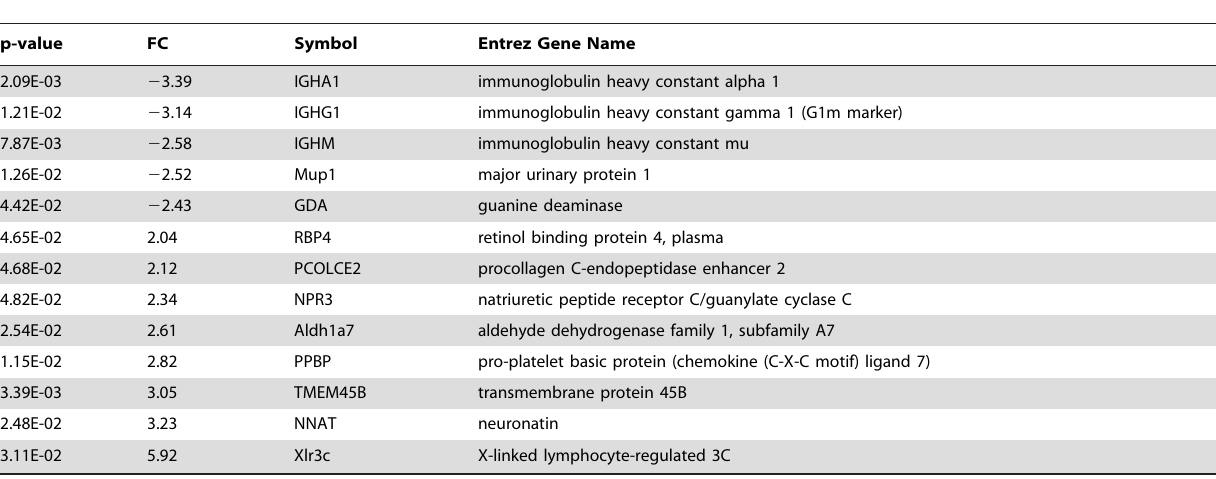
Table 2. Genes differentially expressed in WT vs. H 3 RKO LN after CFA treatment.